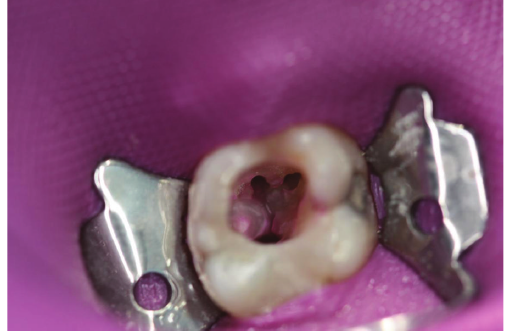
Figure 3: Root canal orifices after enlargement during endodontic